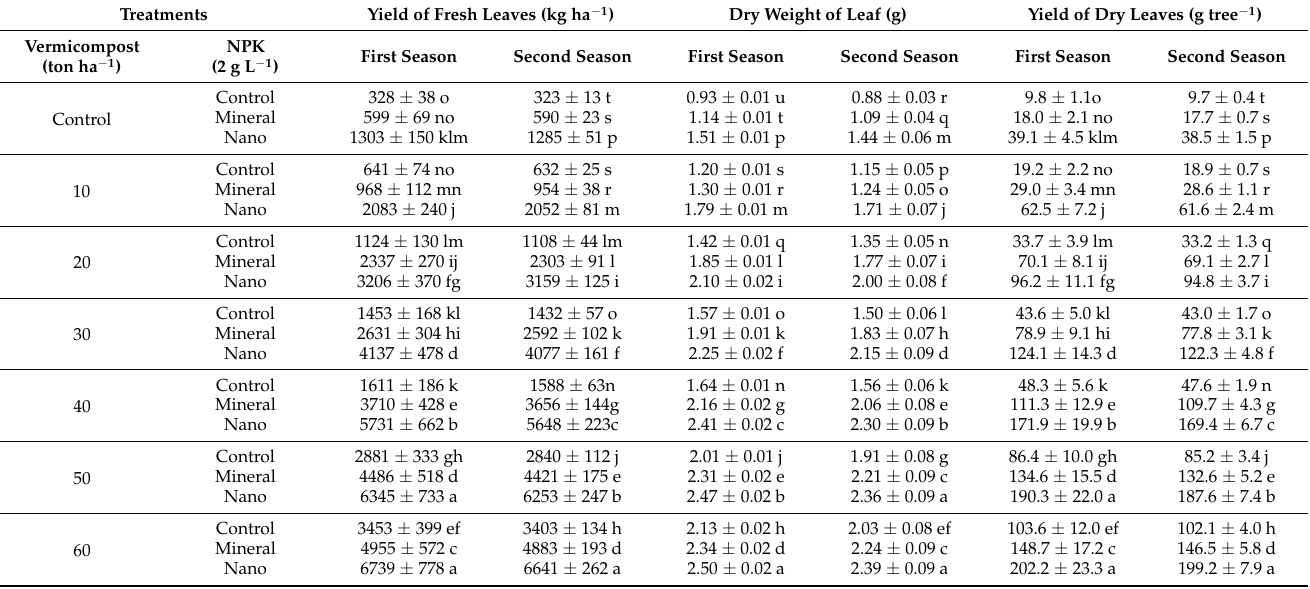
Table 3. The influence of combined treatments of vermicompost and NPK fertilization on the mean values of yield of fresh leaves (kg ha − 1 ), dry weight of leaf (g), and yield of dry leaves (g tree − 1 ) of Moringa oleifera trees in the first and second seasons.